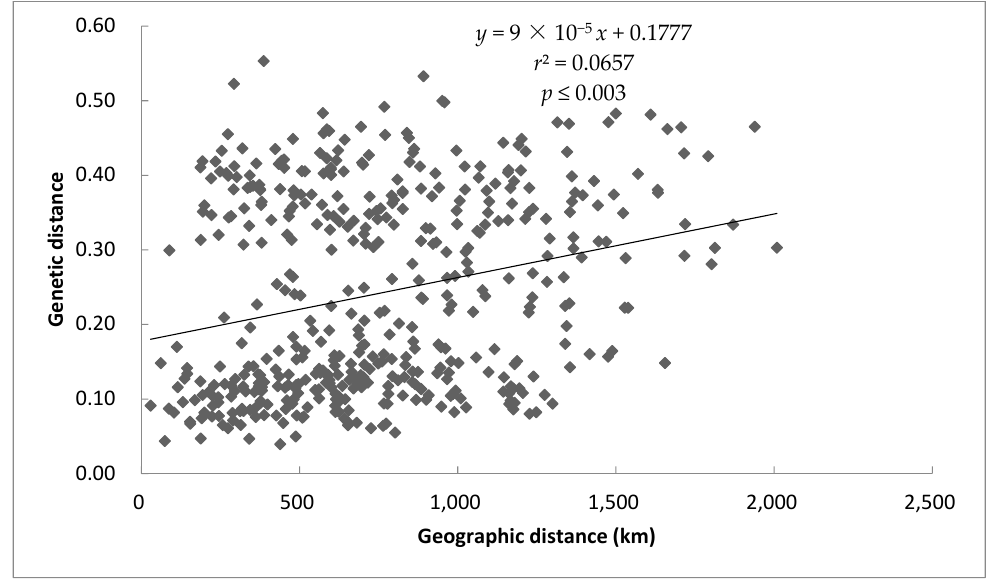
Figure 6. Correlation between the geographic distance ( x ‐ axis) and Nei’s genetic distance ( y ‐ axis).